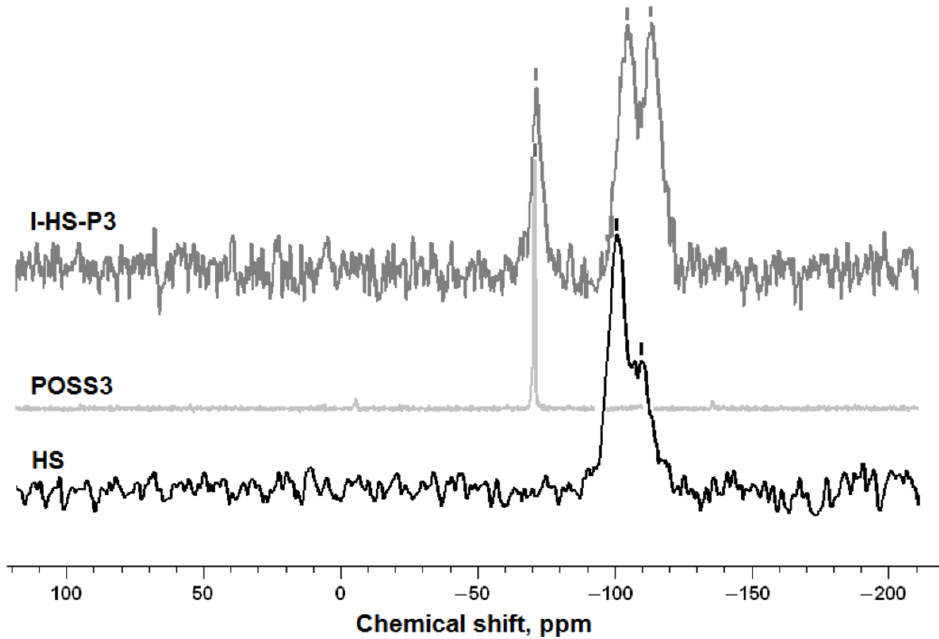
grafted with POSS3 2